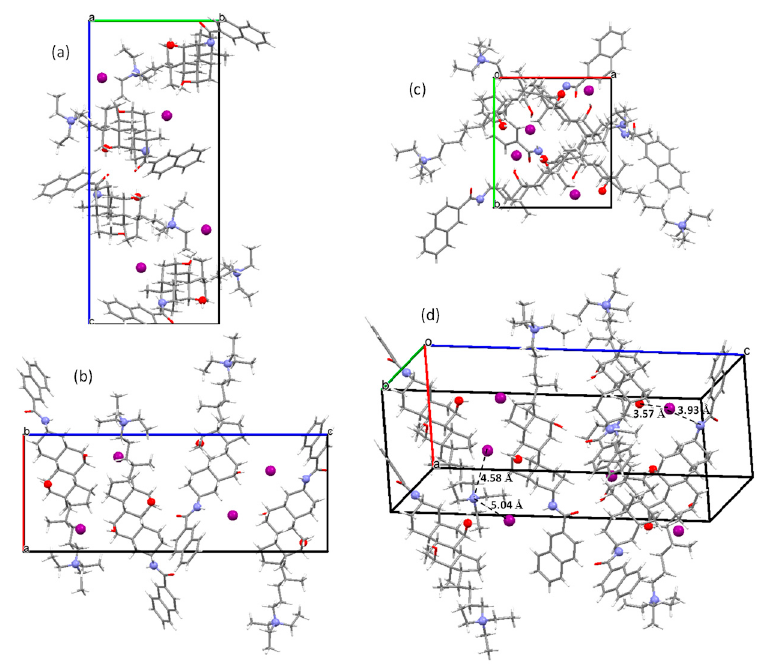
Figure 2. The views of the crystal packing in 1 along the a ( a ), b ( b ) and c ( c ) crystallographic axes. ( d ) An arbitrary view that allows for the reflectance of relevant distances and interactions involving the iodide ion (see text).